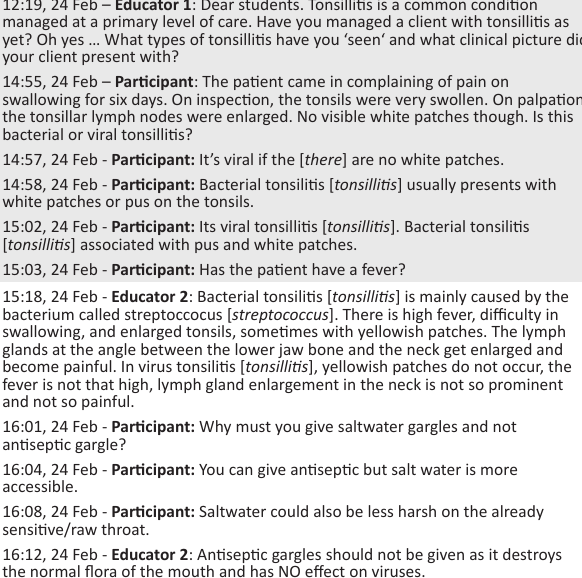
TABLE 1: Strategies to ensure trustworthiness. Strategy Application Credibility